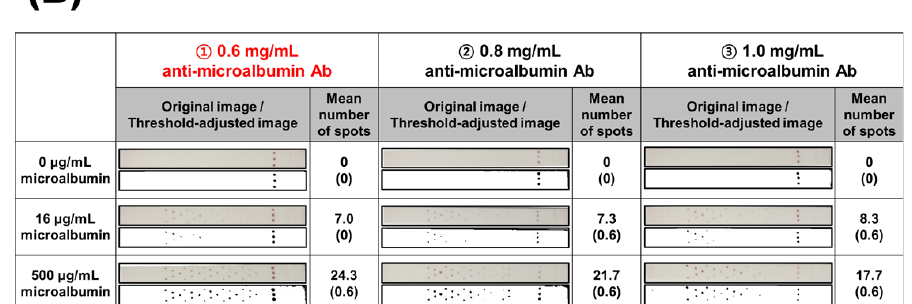
Figure 4. Optimization of capture antibody concentration in the test zone. ( A ) A graph representing the number of colored spots on strips using three different concentrations of capture antibody. ( B ) Original and threshold-adjusted images obtained from the immunoassay strip. The SD values are shown in parentheses.